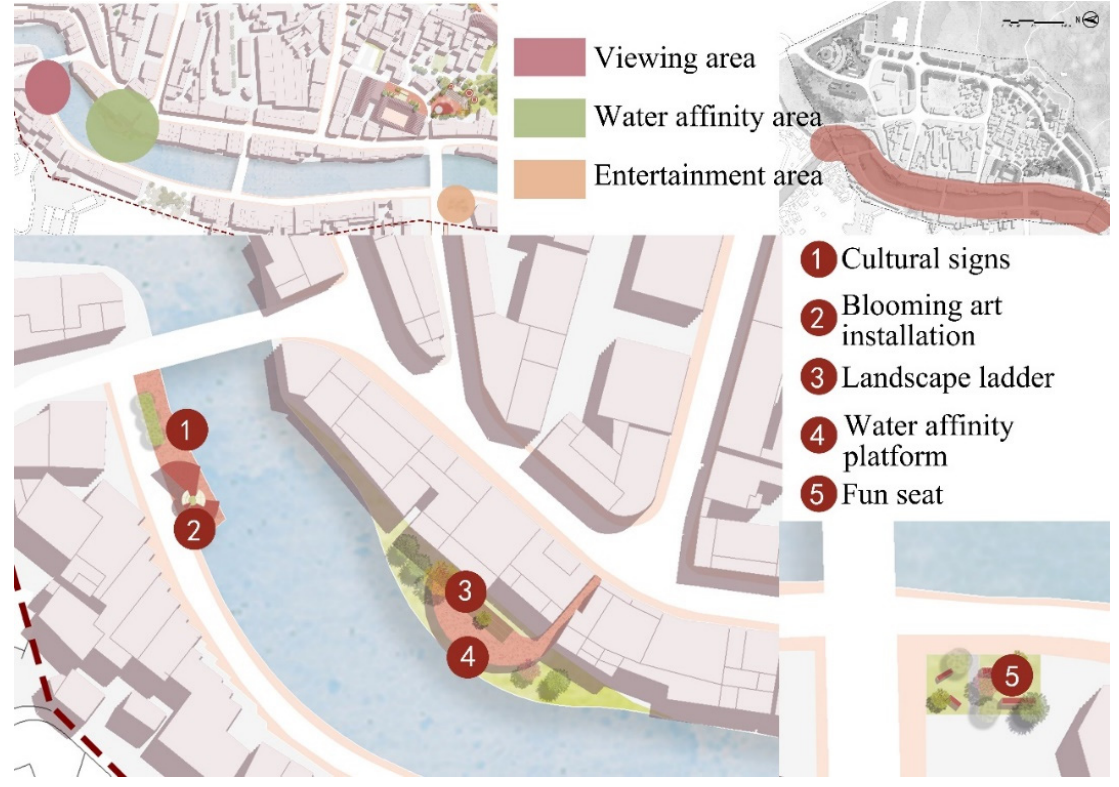
Figure 22. Plan of Leisure tour experience zone landscape.